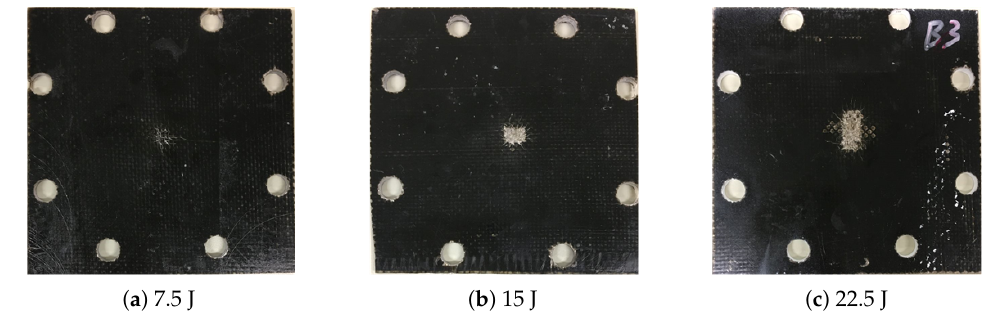
Figure 1. Photographs of the BFRP laminates from the back